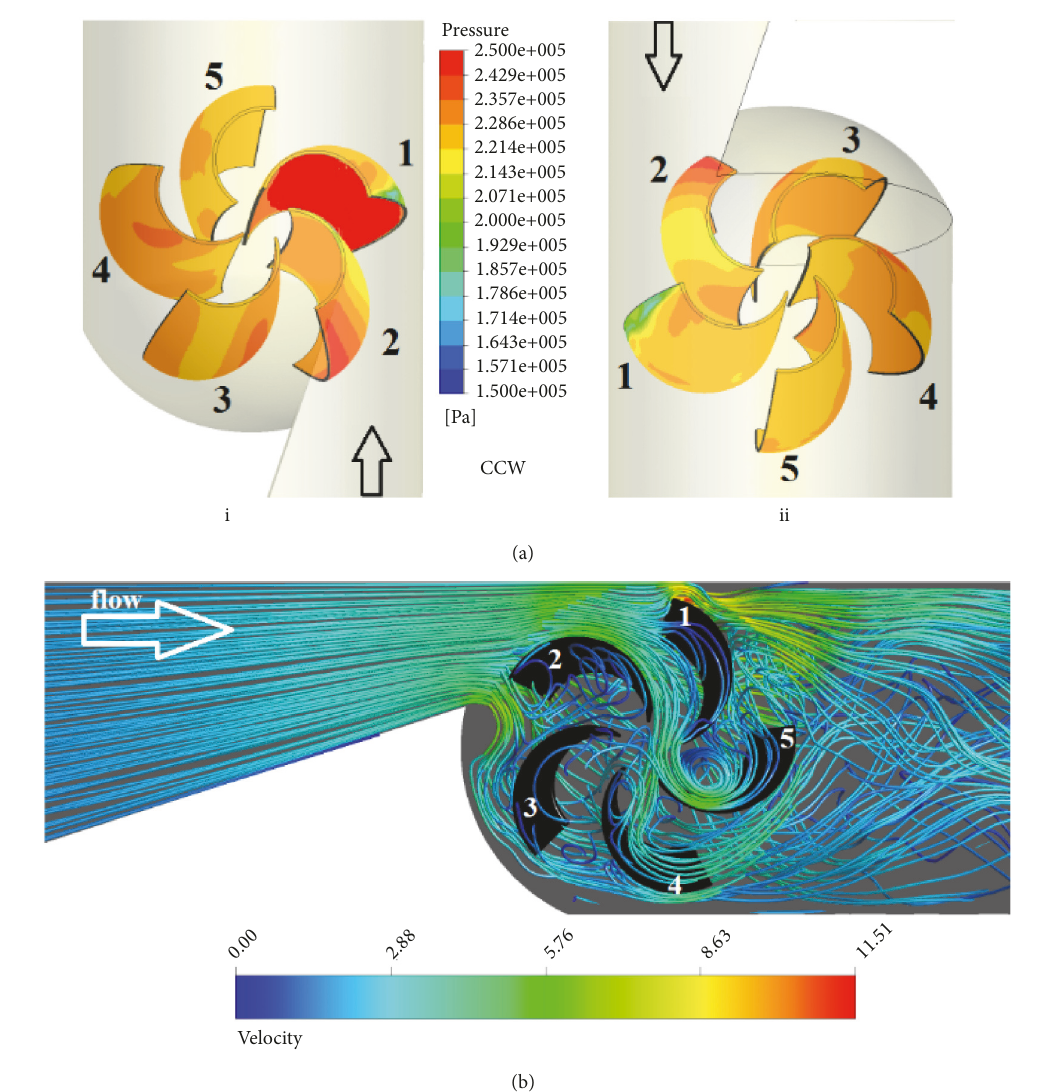
Figure 11: The simulated fluid flow around the 5-bladed turbine. (a) pressure contours (i) in the direction of flow view and (ii) in the opposite direction of flow view and (b) top view of